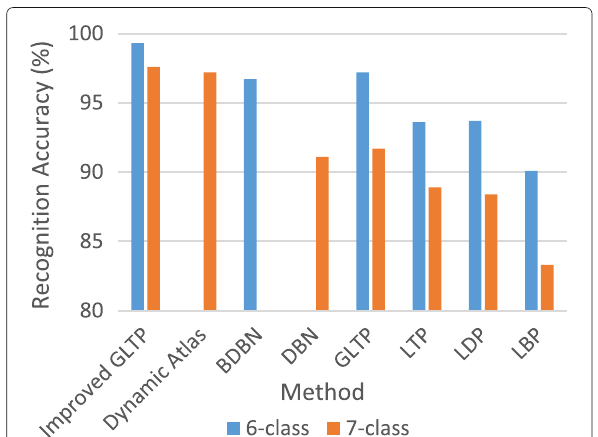
Fig. 13 Comparison of feature selection methods on CK dataset